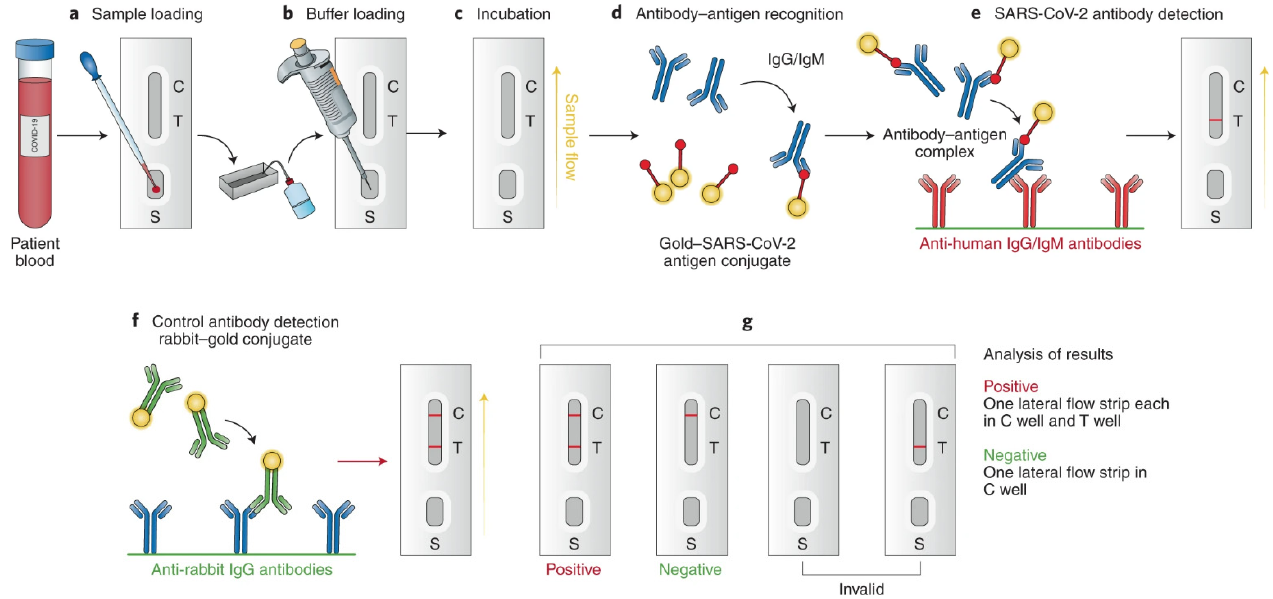
Figure 6. Antigen detection associated with the SARS-CoV-2 virus. Reprinted with permission from Springer Nature [32], Copyright (2021).